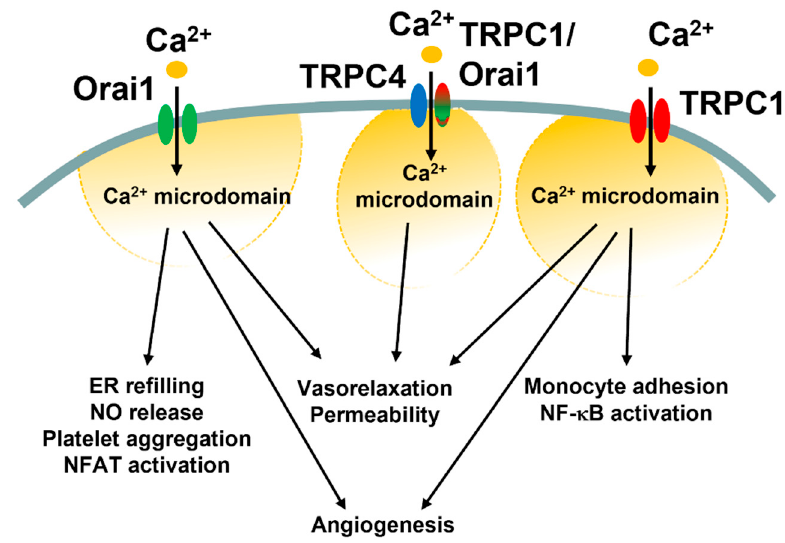
Figure 5. Endothelial functions regulated by Ca 2+ entry through the diverse SOCE mechanisms. This illustration summarizes the different endothelial functions regulated by the ICRAC (Orai1 in green), I CRAC -like currents (TRPC4 in blue plus TRPC1/Orai1 in red/green), and I SOC (TRPC1 in red).